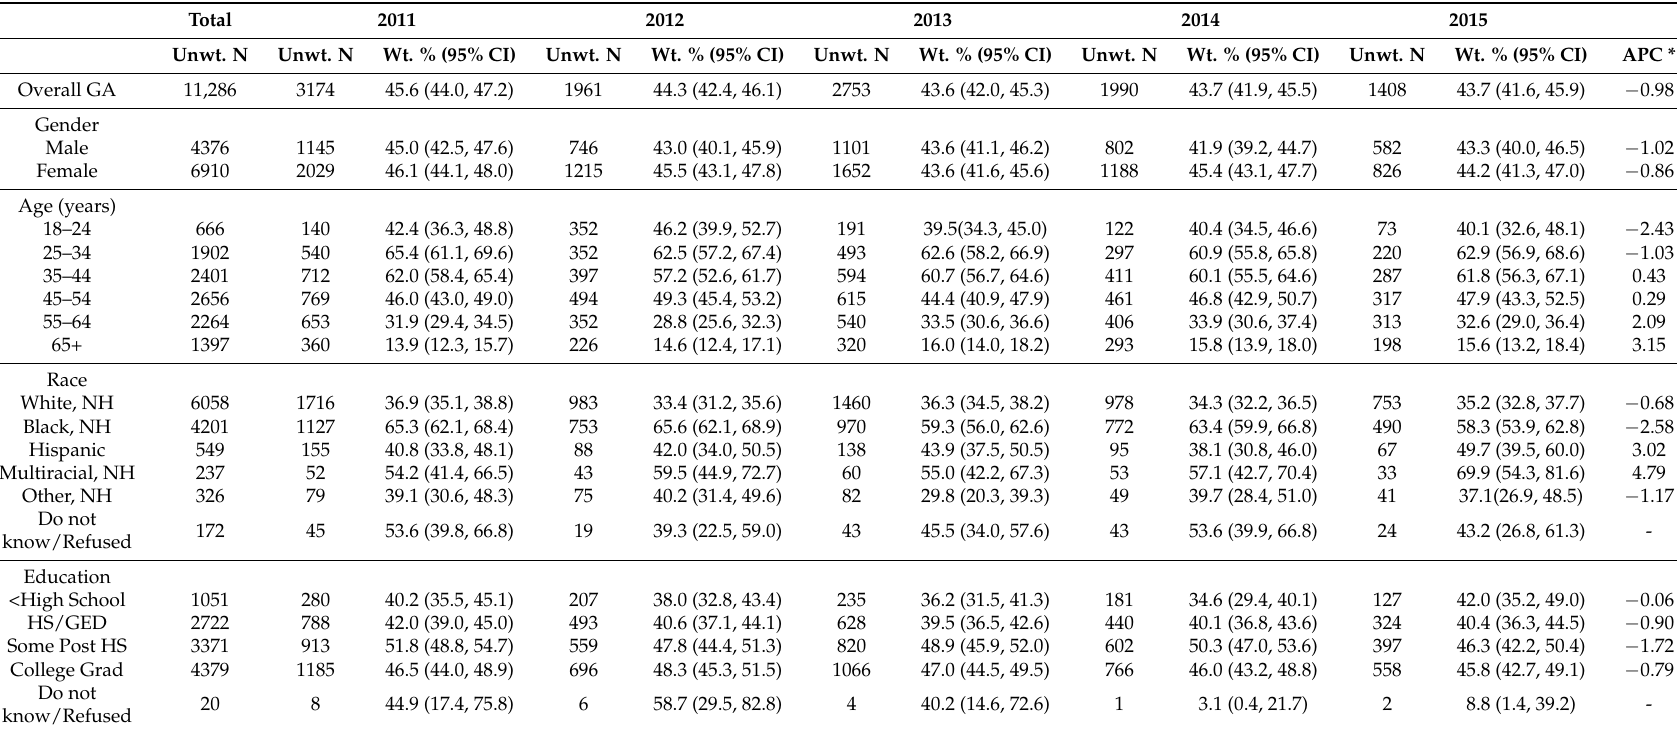
Table 2. Weighted percentages and annual percent change of adults who have ever been tested for HIV in Georgia by year of interview: 2011–2015 BRFSS